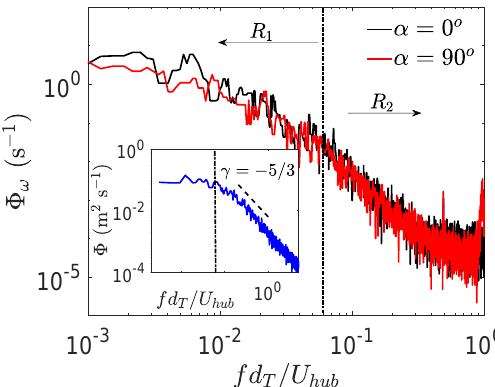
Figure 4. Spectra of instantaneous turbine rotation speed Φ ω under different α . The subplot shows the spectra of incoming velocity at hub height. The vertical dashed line separates the turbulence from energy containing sub-range ( R 1 ) to inertial sub-range ( R 2 ).